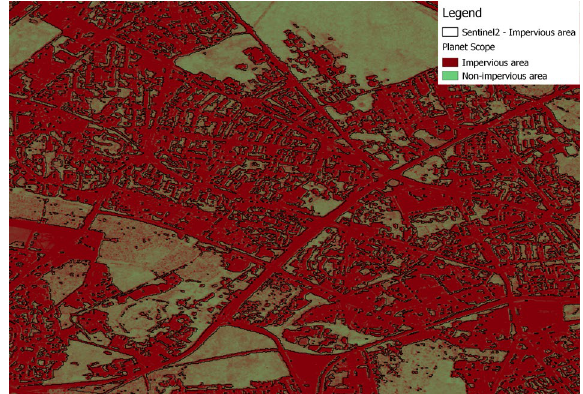
Fig. 6. Comparison of SENTINEL - 2 NDVI products with Planet Scope.